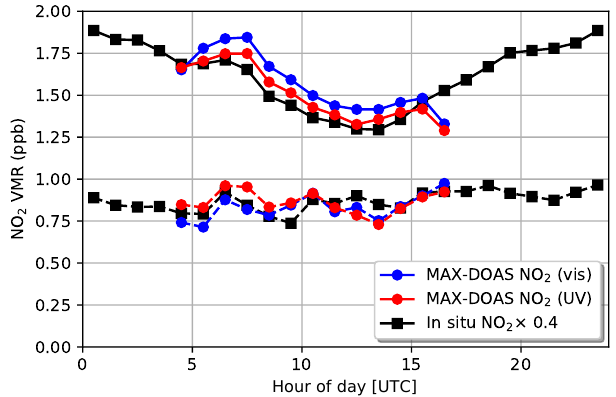
Figure 14. Average diurnal cycle of MAX-DOAS (UV and visible) and in situ NO 2 volume mixing ratios for all measurements (solid lines) and for a subset of measurements with wind from the open North Sea (dashed lines). For a better visual comparability, the in situ values are scaled by a factor of 0.4.